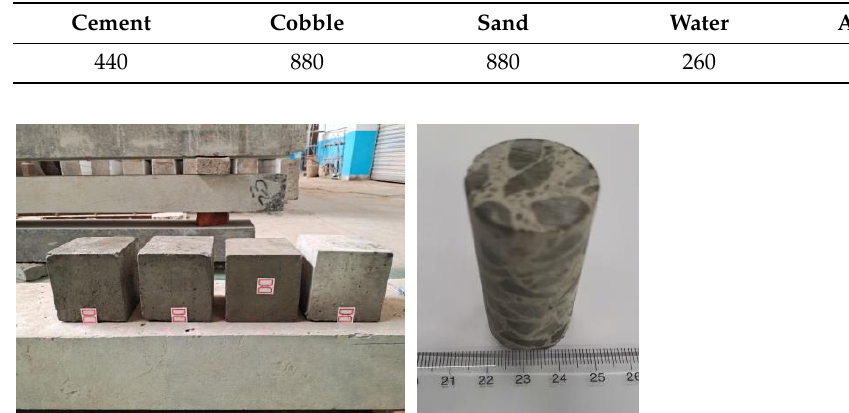
Table 1. The mix proportion of plain concrete kg/m 3 .